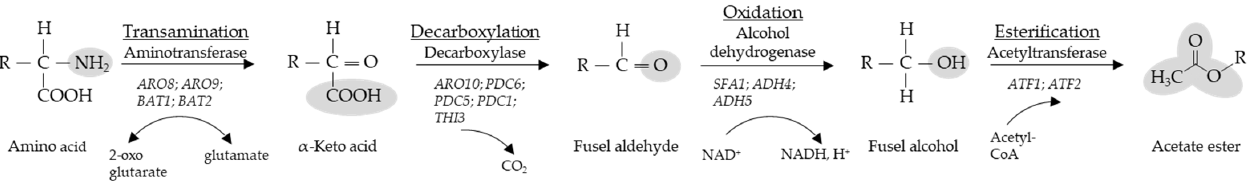
Figure 1. The Ehrlich pathway. Conversion of amino acids into fusel aldehydes, fusel alcohols and acetate esters. Enzymes and encoding genes known in S . cerevisiae to catalyze the reactions are indicated. Specific molecular groups are highlighted. Modified from Hazelwood et al. [10].